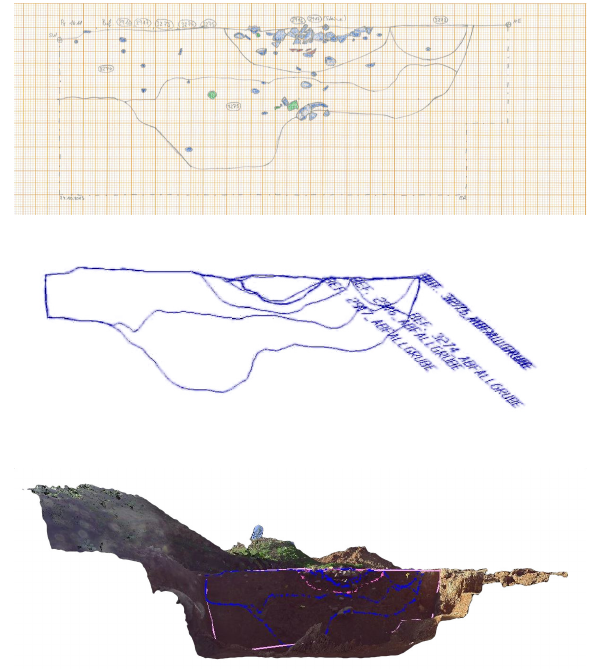
Figure 14: Top: Conventional hand drawing presentation of the excavation. Middle: 2D CAD model of the excavation based on the digital documentation. Bottom: Marked region of interest on a 3D point cloud of an